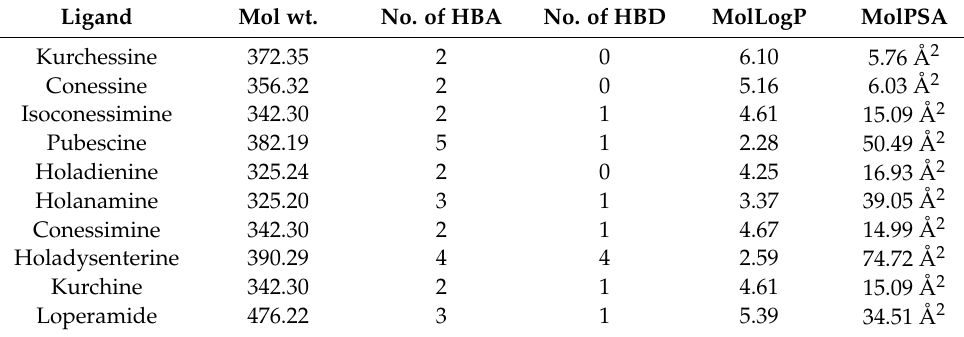
Table 3. Physicochemical parameters of the